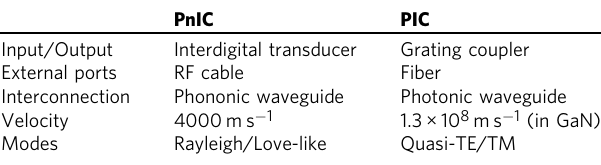
Table 2 Comparison between the PnIC and the